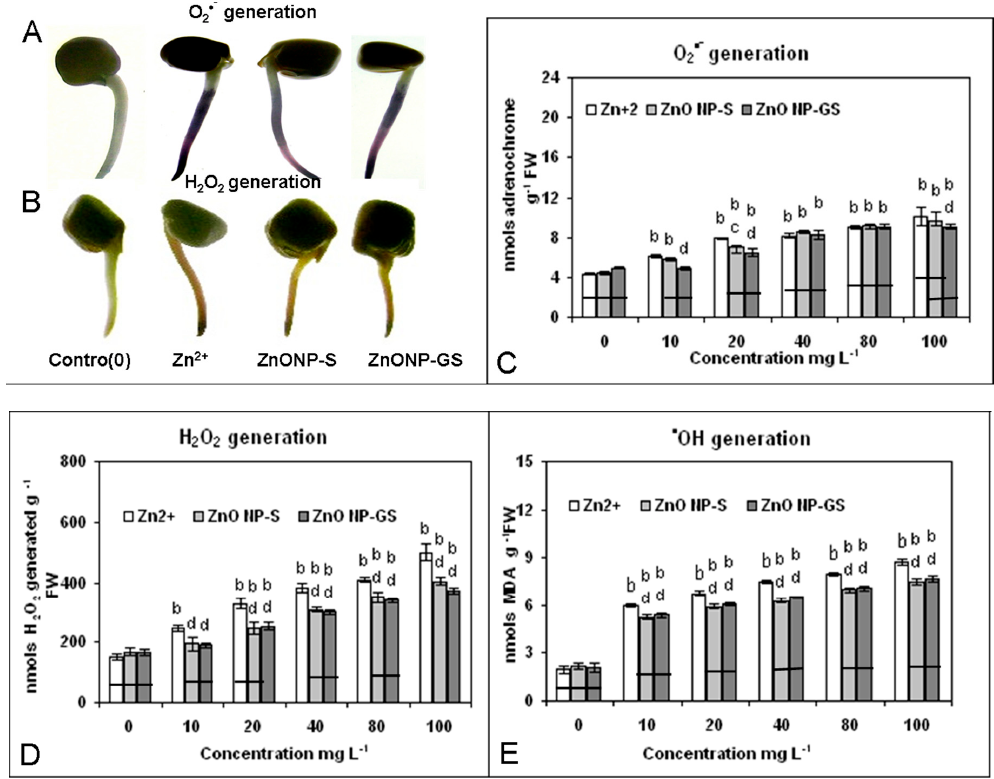
Figure 6. Cytochemical visualization of ( A ) O 2• − , ( B ) H 2 O 2 in roots of germinating seeds treated with